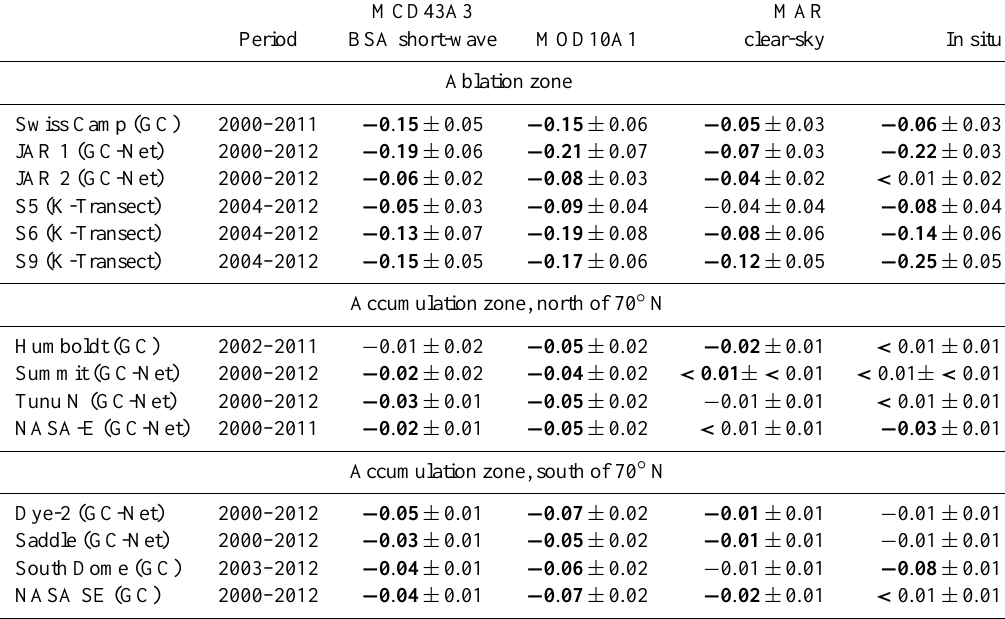
Table 6. Trends (and 95% confidence intervals) in JJA albedo (fraction per decade) at GC-Net and K-Transect weather stations and the nearest MOD10A1, MCD43A3, and MAR pixels. In this case, MODIS data flagged as “other quality” have been included. Only 16 day periods when coincident estimates are available for all data sets have been used. Values in bold indicate trends significant at the 95% confidence